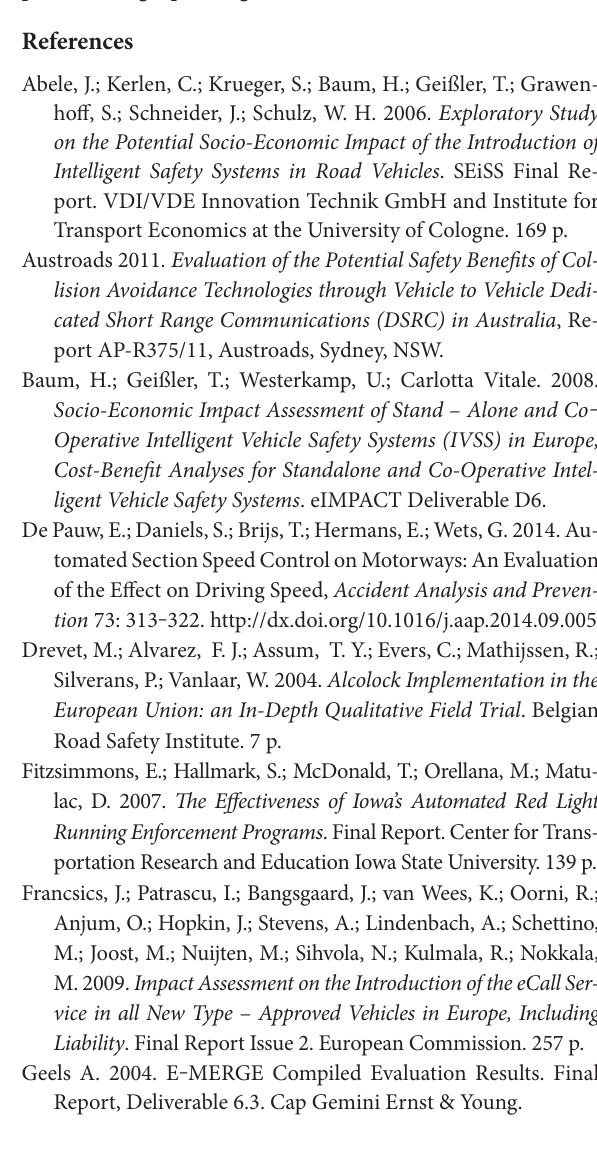
Table 3. Comparison of experts’ interview and meta-analysis results